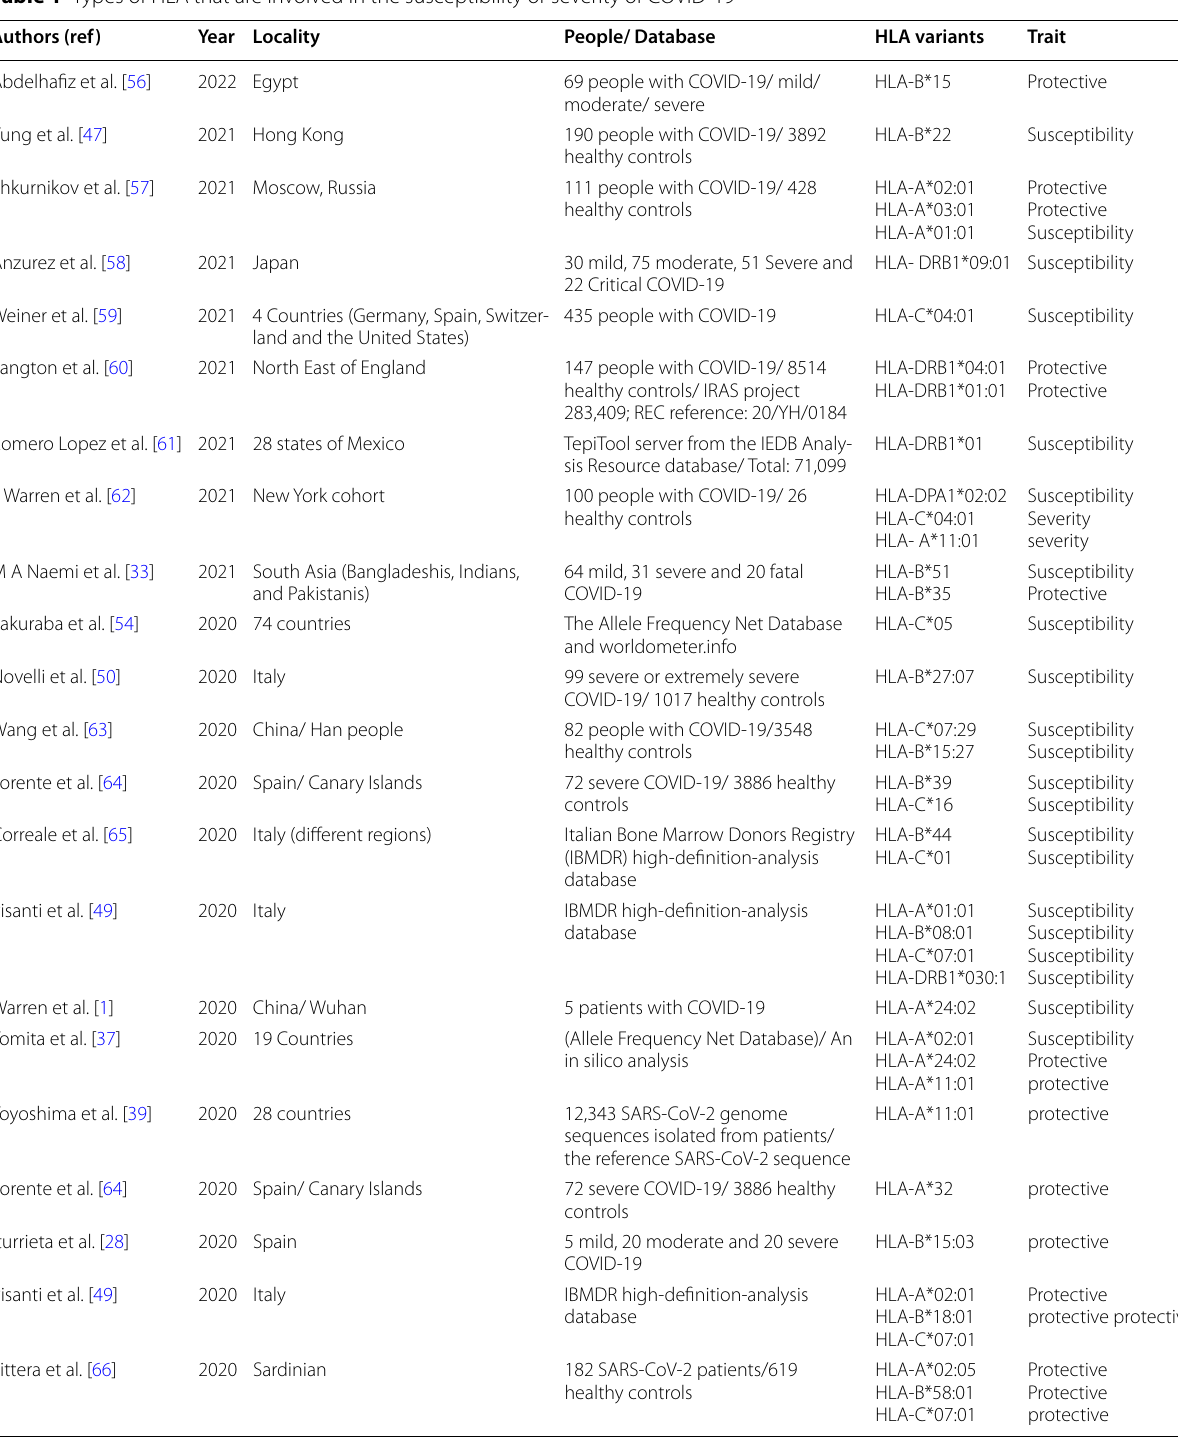
Table 1 Types of HLA that are involved in the susceptibility or severity of